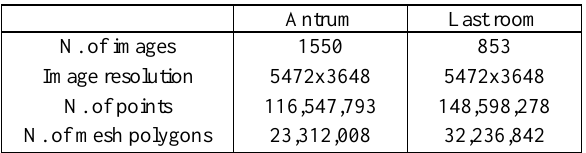
Table 2. Photogrammetric models’ information